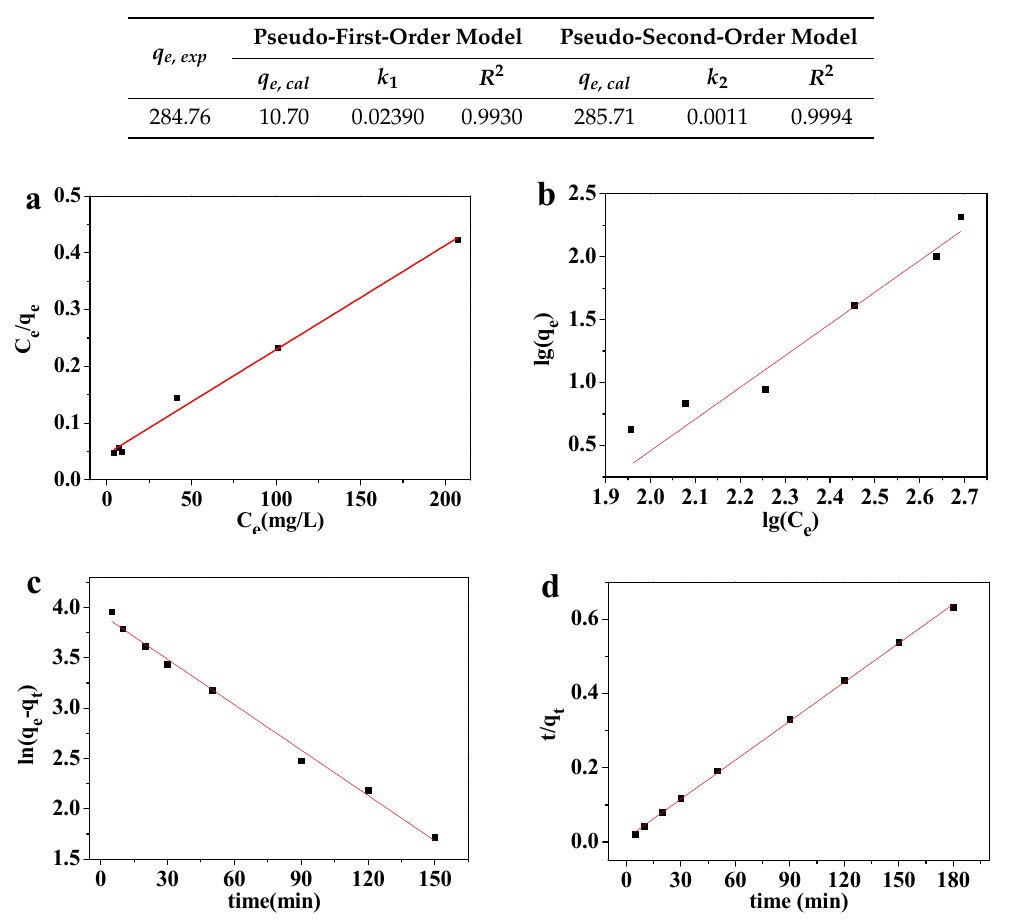
Table 4. Kinetic models parameters for the Pb(II) removal by MIL-101-TEPA@CA.